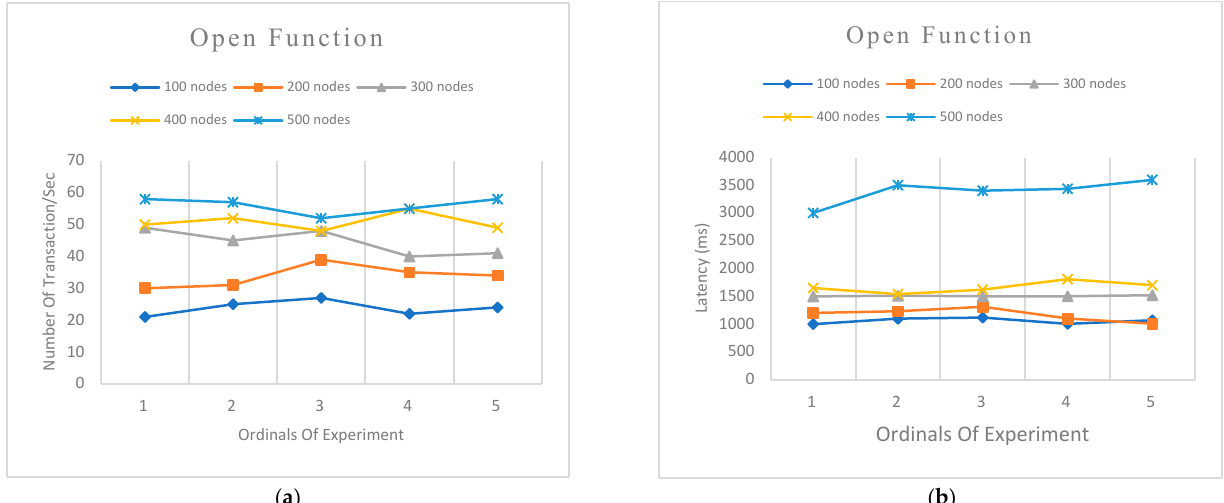
Figure 9. System ( a ) Transactions per second (TPS) of open function with varying node groups ( b ) Latency of open function with varying node groups. Latency: Figure 10 shows the average latencies of query functions and open functions.